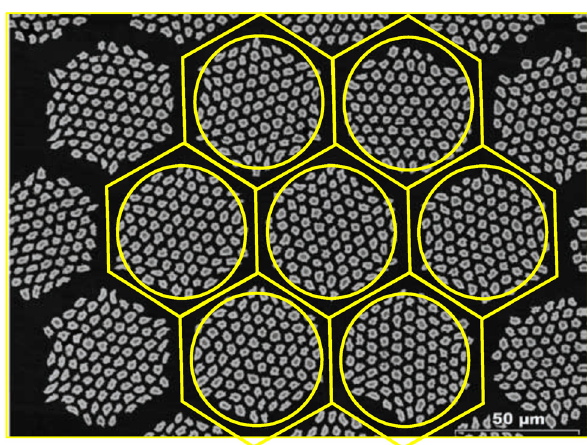
Figure 2: Mesoscale structure of multiple fi lament groups and corresponding hexagonal unit cell representation. ( Reprinted from ref. [ 13 ] , with copyright permission from Elsevier ) .